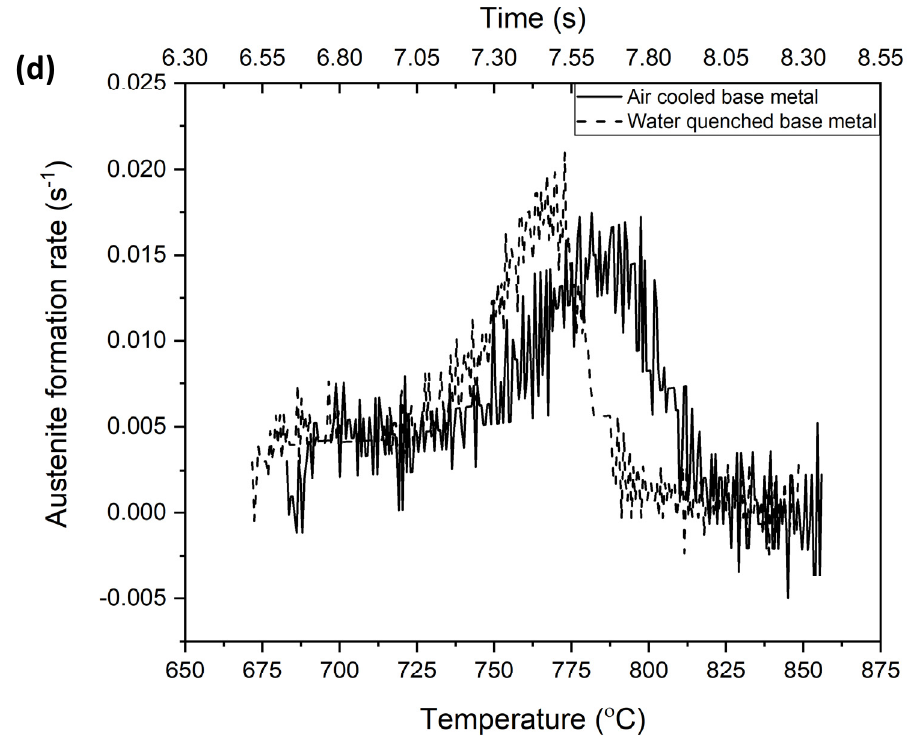
Figure 9. On heating dilatation and the corresponding derivative for the air-cooled initial microstructure ( a ), and for the water-quenched initial microstructure ( b ), and ( c ) austenite phase fraction and transformation ( d ) for air-cooled and water-quenched initial microstructure.